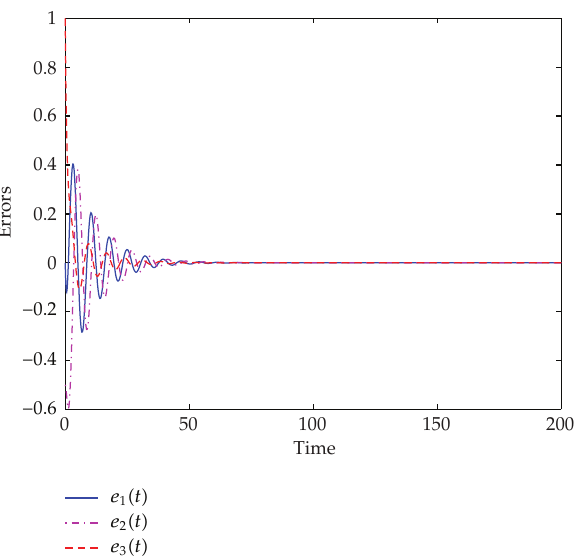
Figure 7: Synchronization errors in Case 1.